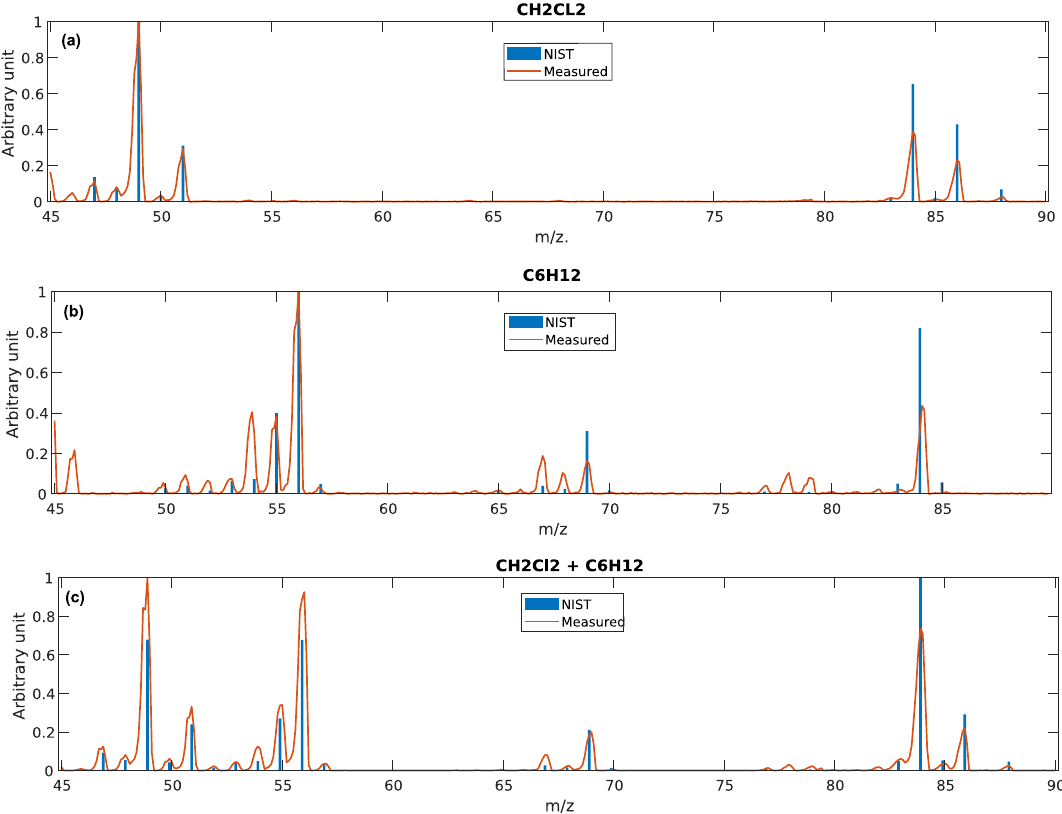
Figure 7. Comparison between acquired spectra and NIST reference for CH 2 Cl 2 ( a ), C 6 H 12 ( b ), and CH 2 Cl 2 + C 6 H 12 ( c